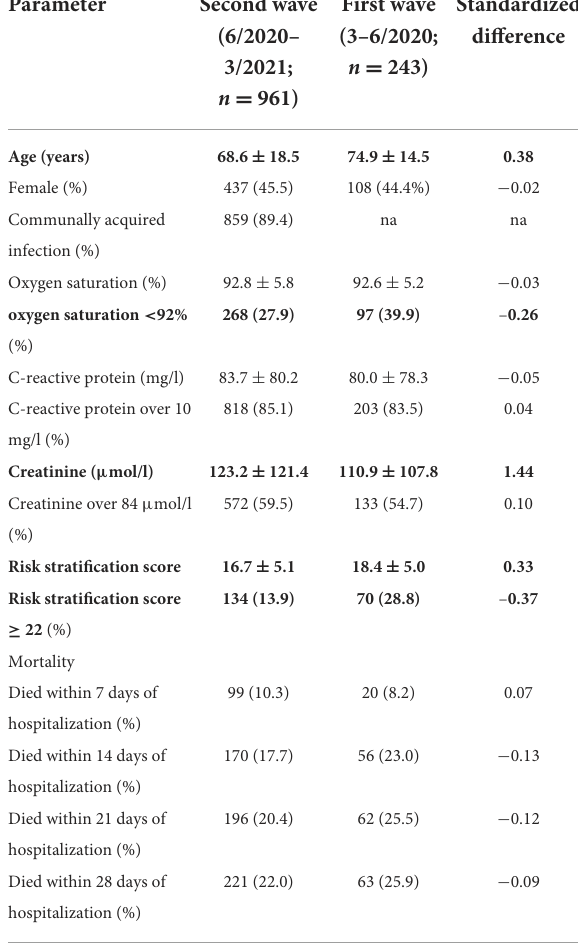
TABLE 1 Patient characteristics of the validation cohort and the patients on which the risk stratification score was based (patients